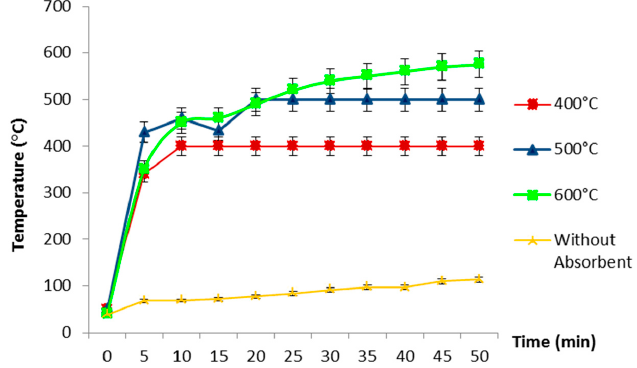
Figure 2. Temperature profiles of waste shipping oil during microwave pyrolysis at different temperatures. The data presented are means ± SD of three valid runs ( N = 3) where SD is indicated by the standard deviation bars.